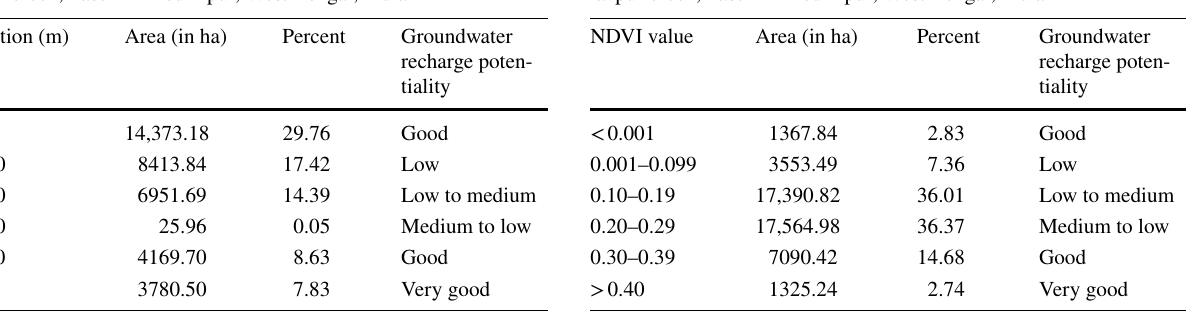
Table 1 Elevation characteristics and their areal extent of Gopibal-